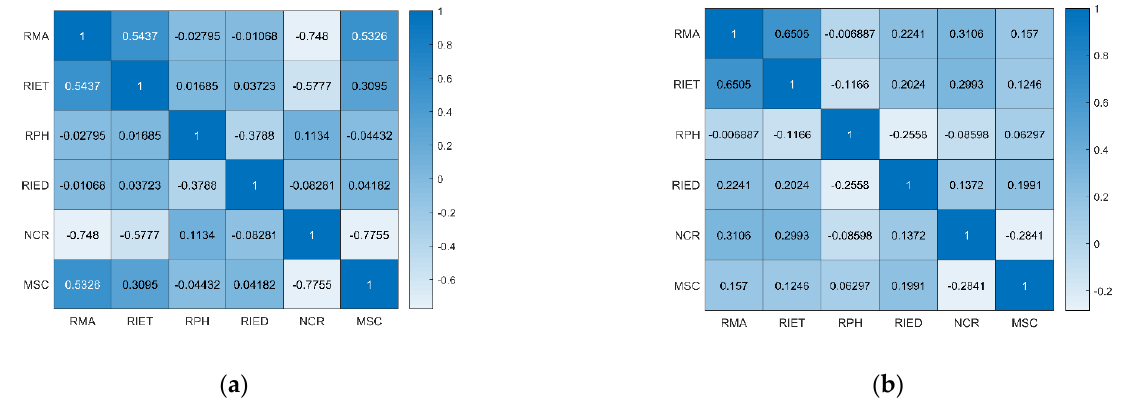
Figure 13. Characteristic correlation analysis of target and clutter. ( a ) characteristic correlation of target; ( b ) characteristic correlation of clutter.